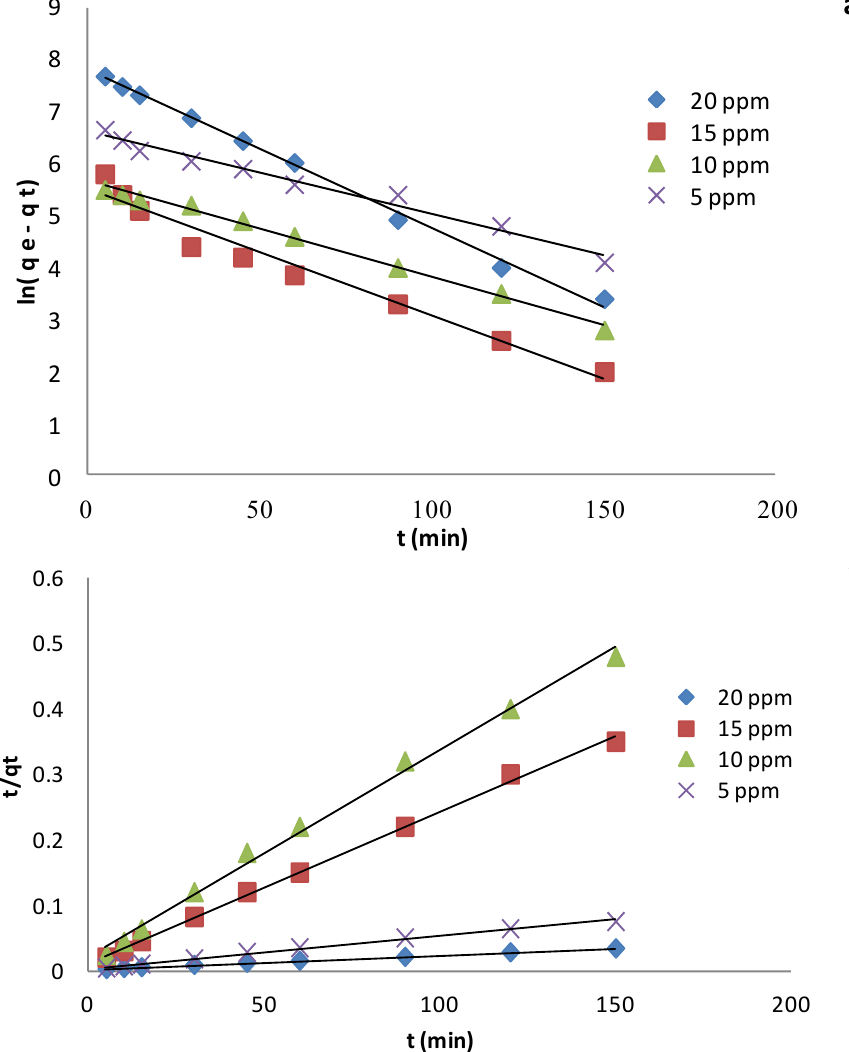
Fig. 9. Pseudo-first-order (a) and pseudo-second-order (b) kinetic plots for the adsorption process.